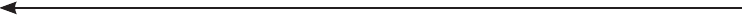
Figure 1: Darkfield colors from arrays of single Al nanodisk gap plasmon resonators. (A) 3D schematic of an array of Al disks on Al O on Al, forming gap plasmon resonators. The disks have diameter d , inter-disk gap g , and 2 3 period P . (B) Light paths in darkfield microscopy, where the central part of the light from the source is blocked by the central stop. Light is sent onto the sample as a hollow cone. The paths followed by the two threshold wavelengths are marked blue and red, respectively. (C) Optical brightfield micrograph taken using a Nikon 20 × /0.45 NA objective. (D) Optical darkfield micrograph taken using a Nikon 50 × /0.8 NA objective. Each square in the micrographs is 10 μ m by 10 μ m in size. The disk diameter range is 60 nm to 280 nm, while the inter-disk gap range is 30 nm to 140 nm. Saturated blue colors appear when the period increases above 250 nm. (E) Darkfield spectra for 280 nm wide disks and inter-disk gaps between 20 nm and 130 nm. The threshold wavelengths for the array with a gap of 30 nm are shown. (F) Fits of the experimental threshold wavelengths to the values obtained from the diffraction grating equation. (G) Wave vector diagram for blue light at the threshold wavelength for complete collection of first-order diffracted light. Light is incident onto the grating in a wedge of angles, where θ and θ correspond to the minimum and maximum polar angles, respectively. All the output angles of the diffracted light in1 in2 from the grating lie within the collection cone of the objective. (H) Wave vector diagram for red light. The output angle of the diffracted light lies just outside the collection cone, so no diffracted light is